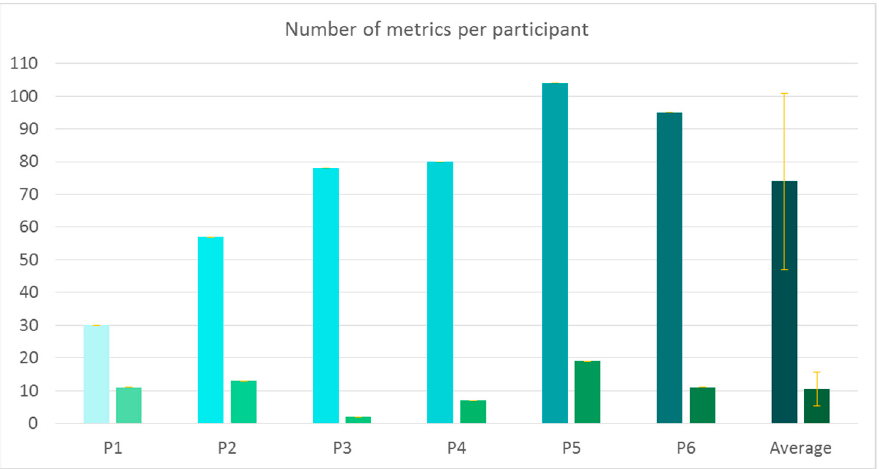
Figure 9. Number of metrics suggested per participant in phase B (first column) and phase A (second column).